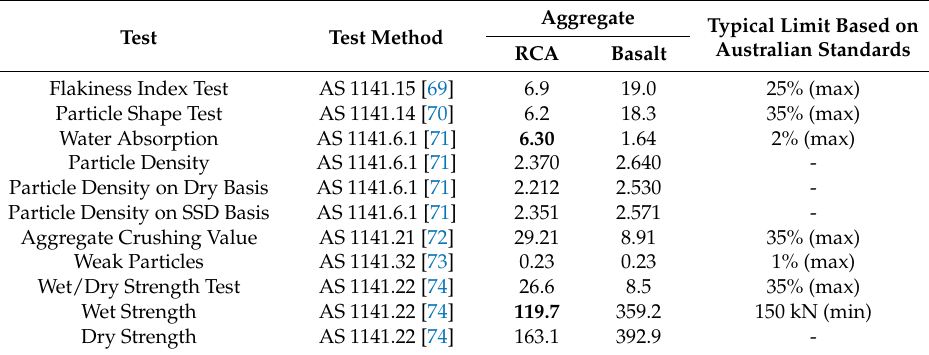
Table 5. Test results for evaluation of coarse aggregate